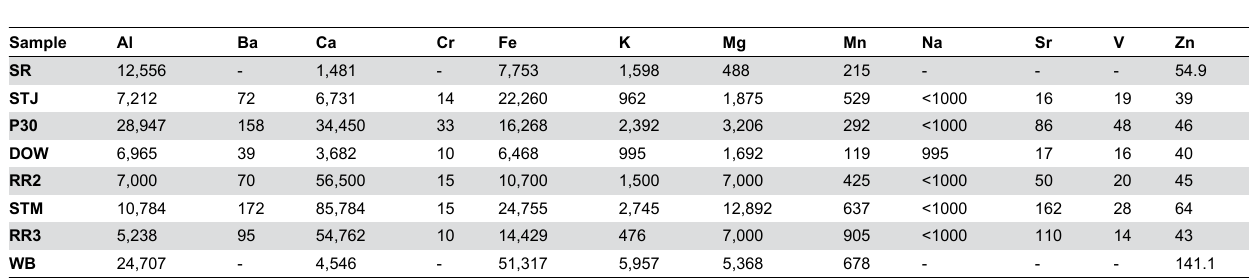
[All values µg/g dry weight. All samples were below detection limits for Be (<0.5), B (<200), Cd(<2), Co (<5), Cu (<10), Mo (<50), Pb (<50).] Table modified from Besser et al.